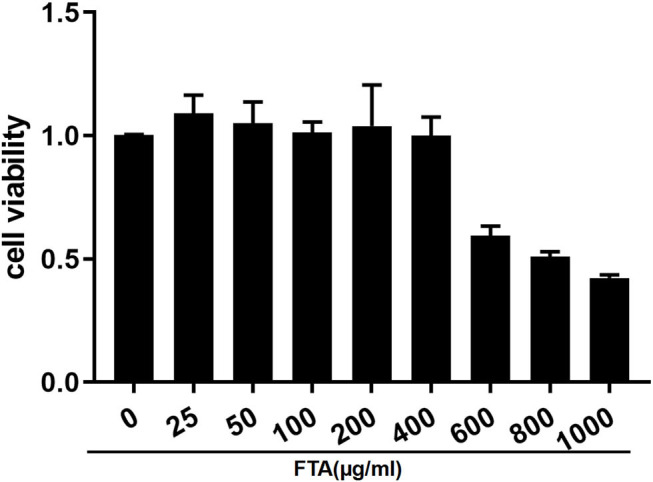
Effect of FTA on bESC viability. Cells were cultured with different concentrations of FTA (25, 50, 100, 200, 400, 600, 800, and 1,000 μg/ml) for 12 h. The cell viability was determined by CCK8 assay. The values presented are the means ± SEM.